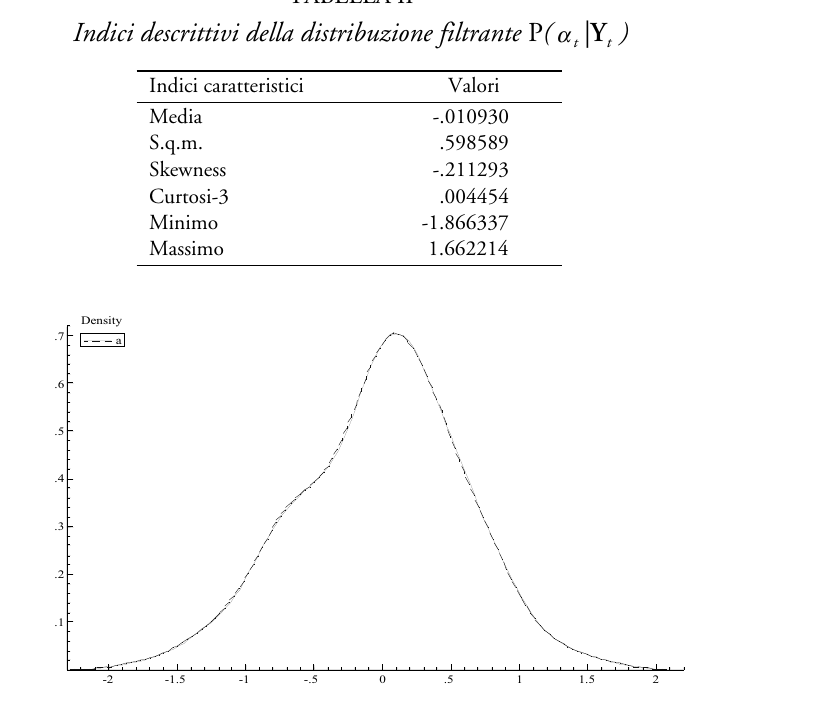
Figura 1 – Funzione di densità filtrante P( α